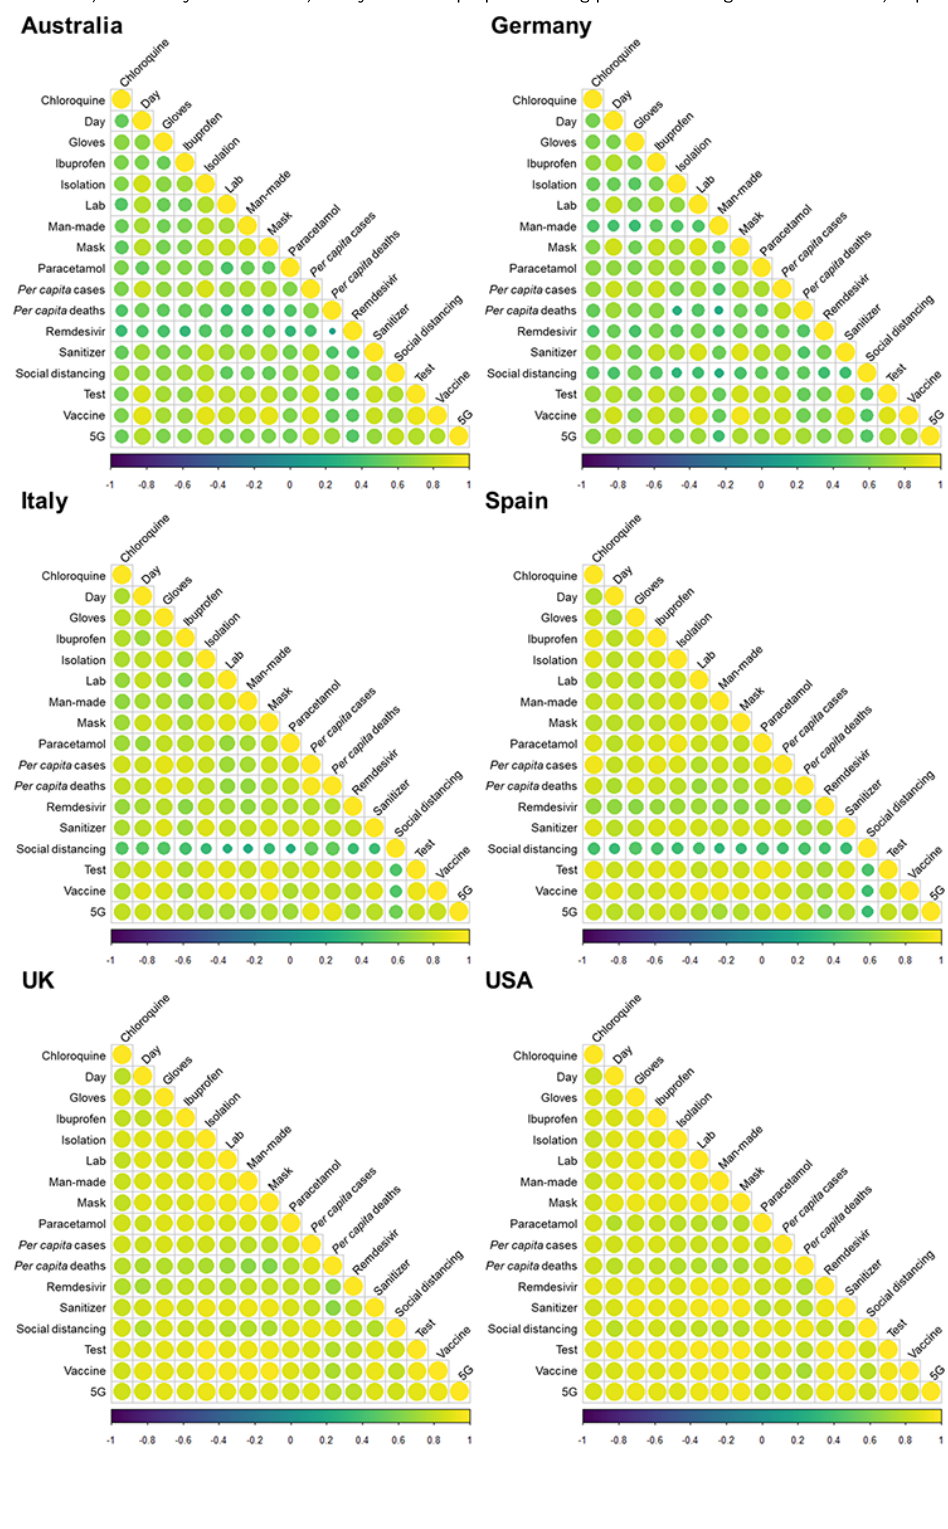
Figure 8. Correlograms for the search factors and per capita case and death rates for each country. The size of each circle indicates the strength of the correlation as does the color, denoted by the scale bar, with yellow and purple denoting positive and negative correlations,